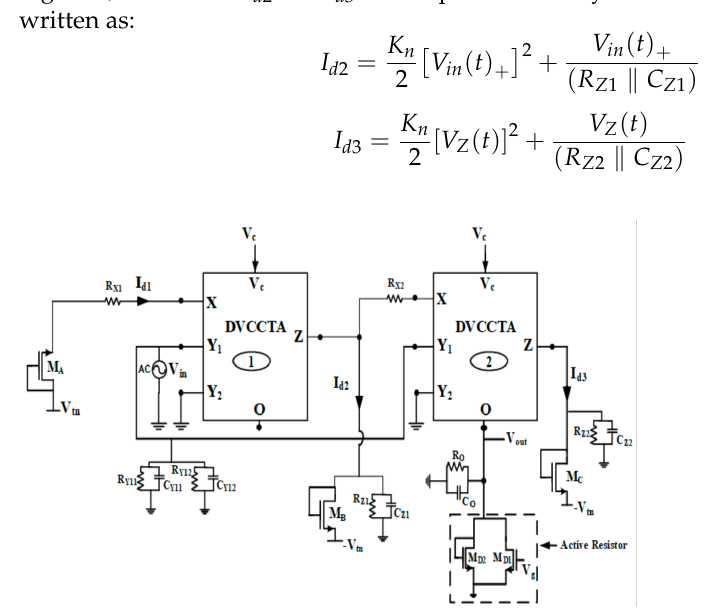
Figure 4. Full-wave rectifier circuit considering